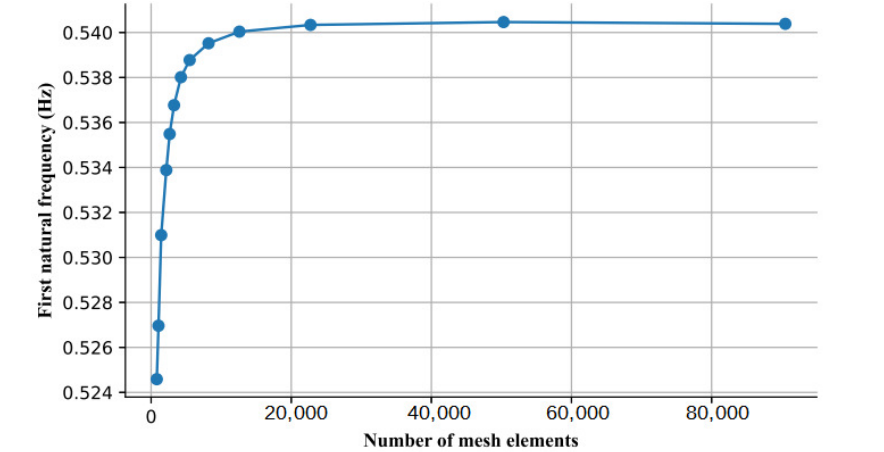
Figure 5. Mesh convergence study to determine the element